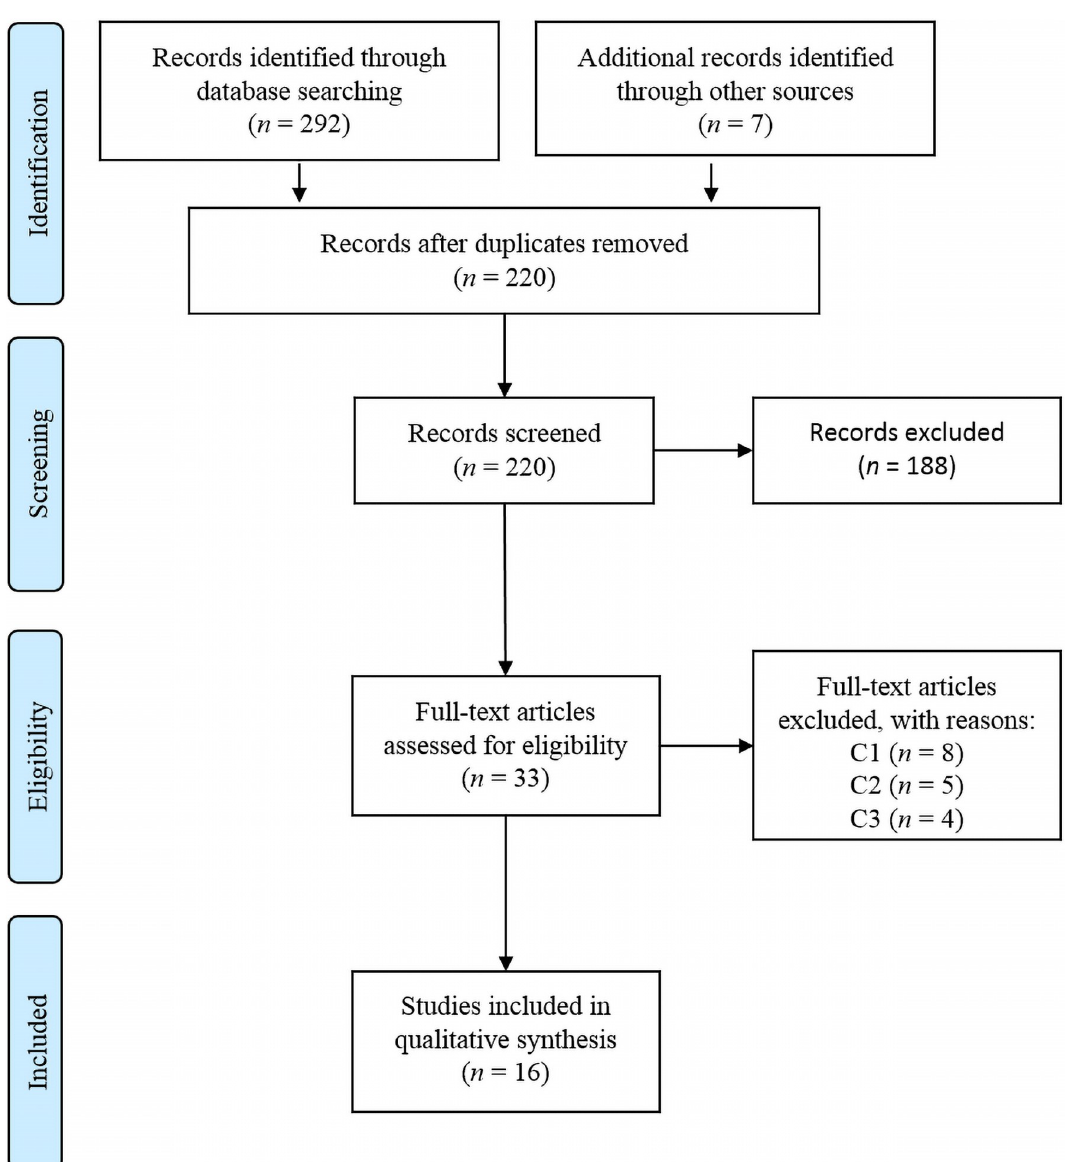
Fig 1. PRISMA diagram of study selection process. Note . C1: non-primary empirical studies; C2: studies in a language other than English or Spanish; C3: no peer review.